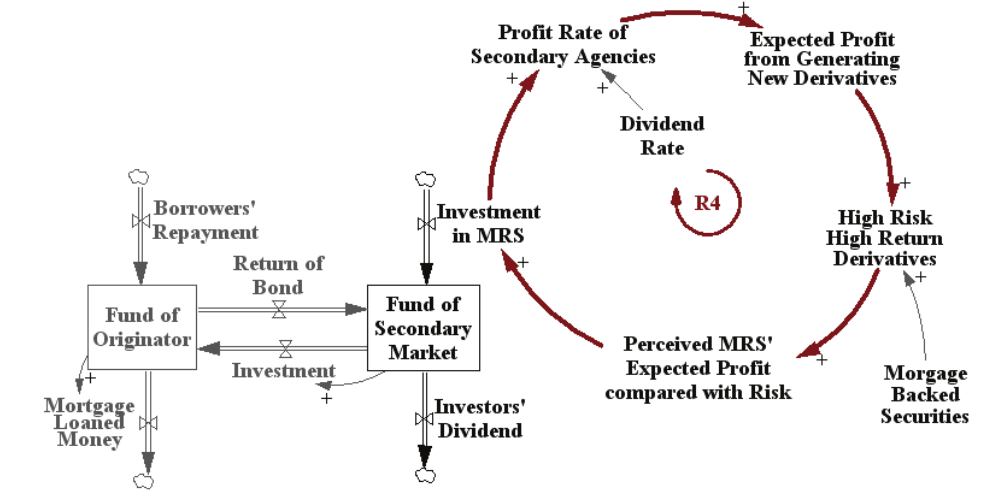
figure 7. Amplification of derivatives generation by mortgage